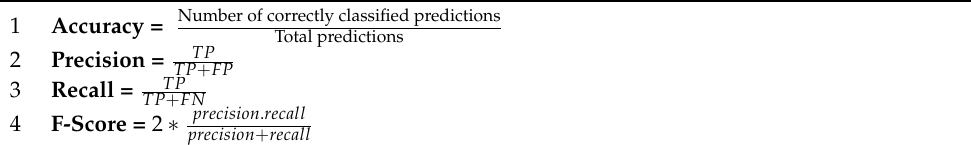
Table 4. Performance Evaluation